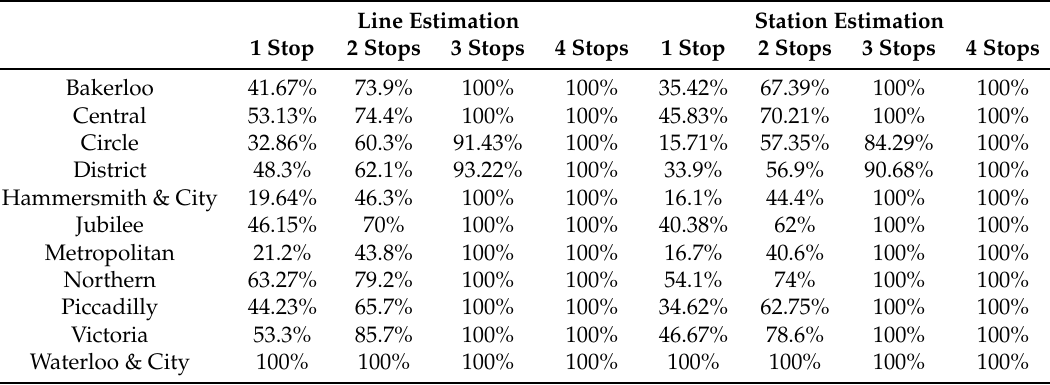
Table 5. The line and station estimation accuracy: Overall, the longer the passenger travels, the more accurate the estimation is. Absolute 100% accuracy was achieved on both line and station estimation when we have at least 4 stations’ length of accelerometer